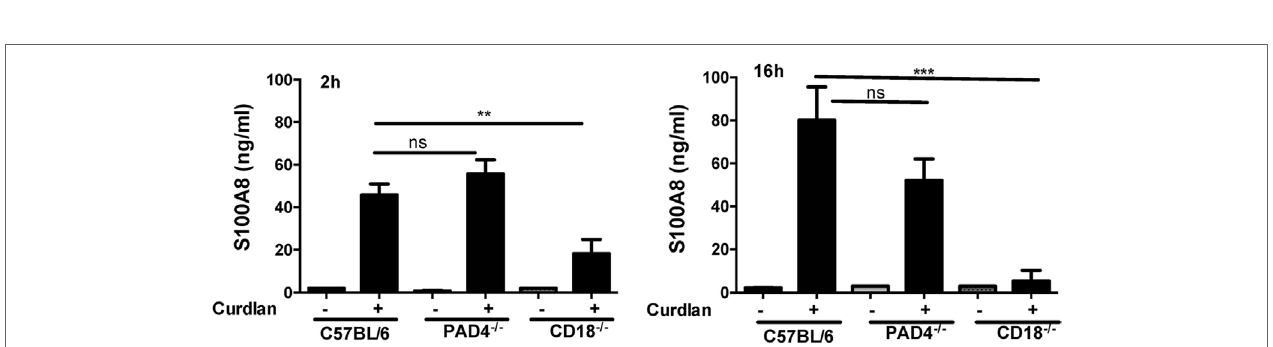
FigUre 5 | Protein deiminase 4 (PAD4)-dependent neutrophil extracellular trap formation. (a) Bone marrow neutrophils from C57BL/6 and PAD4 − / − mice were incubated 20 h with particulate β -glucan (curdlan) in RPMI, and DNA release was quantified by SYTOX Green. Values were normalized to unstimulated neutrophils (RPMI). (B,c) Human peripheral blood neutrophils incubated with curdlan and 10 μ M specific PAD4 inhibitor GSK484 (B) or with the related, non-inhibitory compound GSK106 (c) . p Values are biological replicates of at least three repeat experiments and were calculated using ANOVA with Tukey post hoc analysis (*** p < 0.01; ** p < 0.05; ns, not significant). Experiments were repeated twice with similar results.